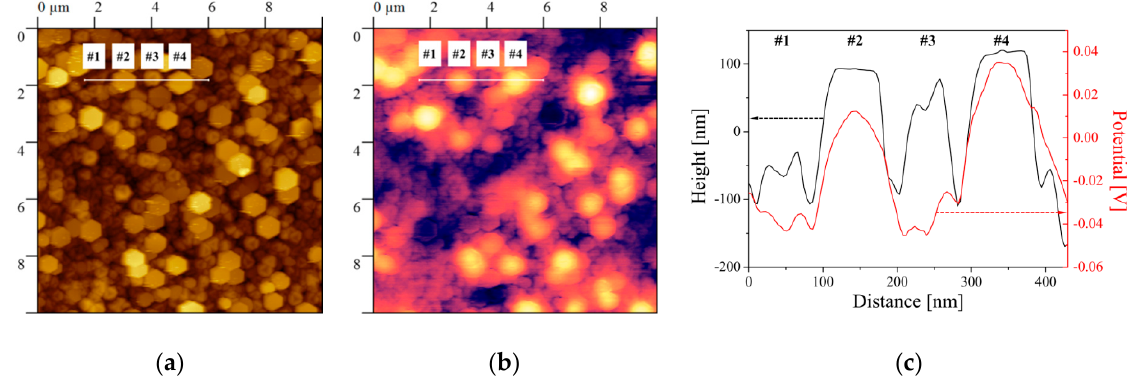
Figure 11. ( a ) Atomic Force Microscopy (AFM) topography (color scale from 0 − 500 nm), ( b ) the Kelvin probe force microscopy (KPFM) contrast map (color scale from 0 − 0.2 V), and ( c ) line-scan profiles of the height (in black) and potential on the surface (in red) through four NWs .